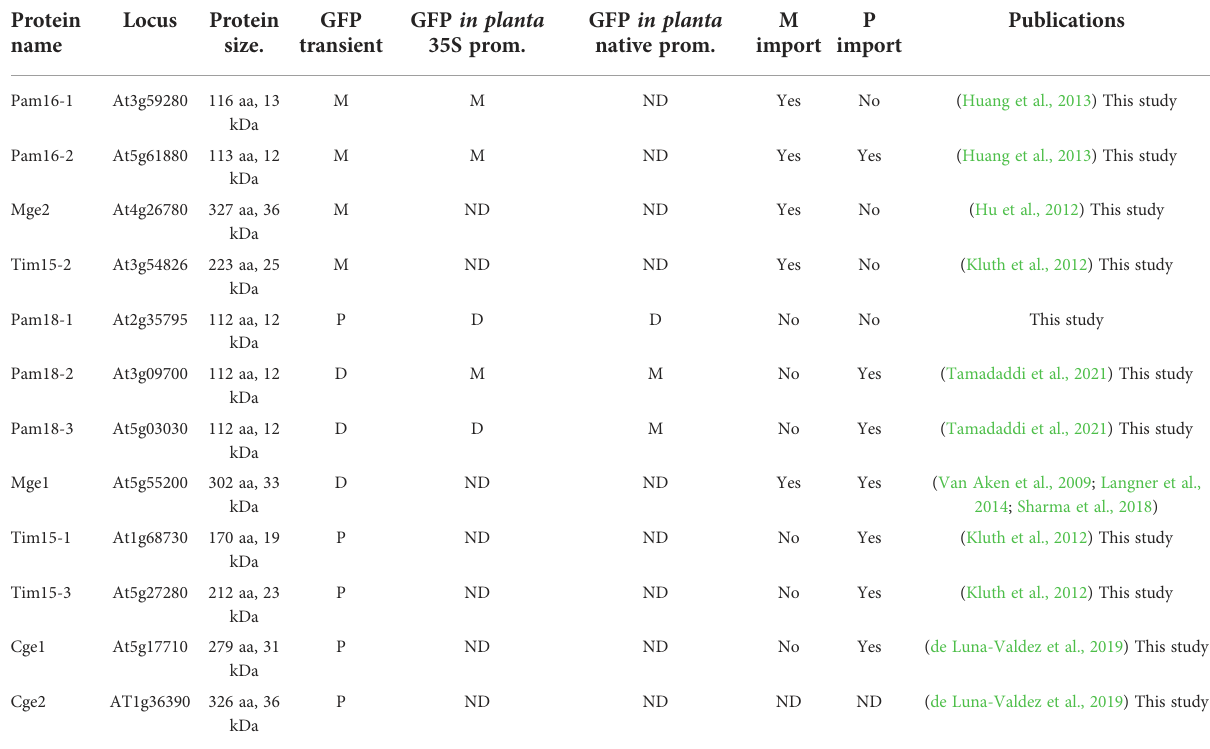
TABLE 1 Summary of